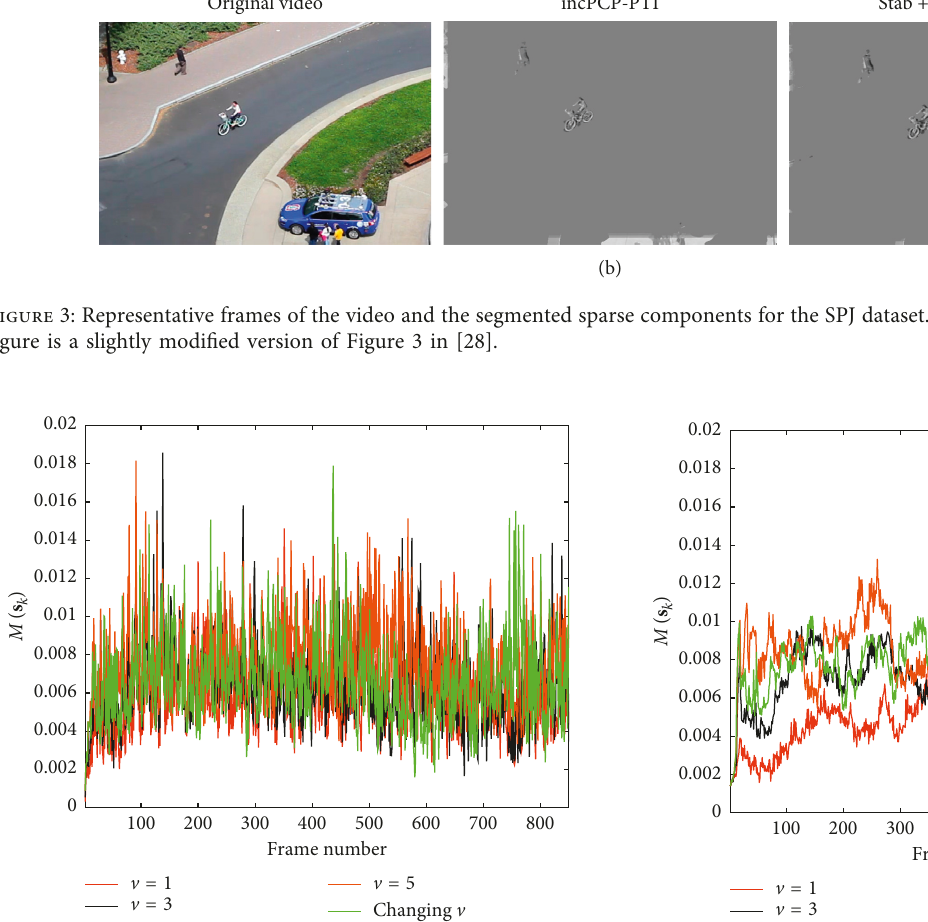
Figure 4: Value of distance M ( s ) between binary mask and Figure 5: Value of distance M ( s ) between binary mask and k k ground truth frames for incPCP-PTI on the SPJ dataset (Figure 5). ground truth frames for stab +incPCP-PTI on the SPJ dataset This figure is a slightly modified version of Figure 4 in [28]. (Figure 4 and Section 4.1). This figure is a slightly modified version of Figure 5 of